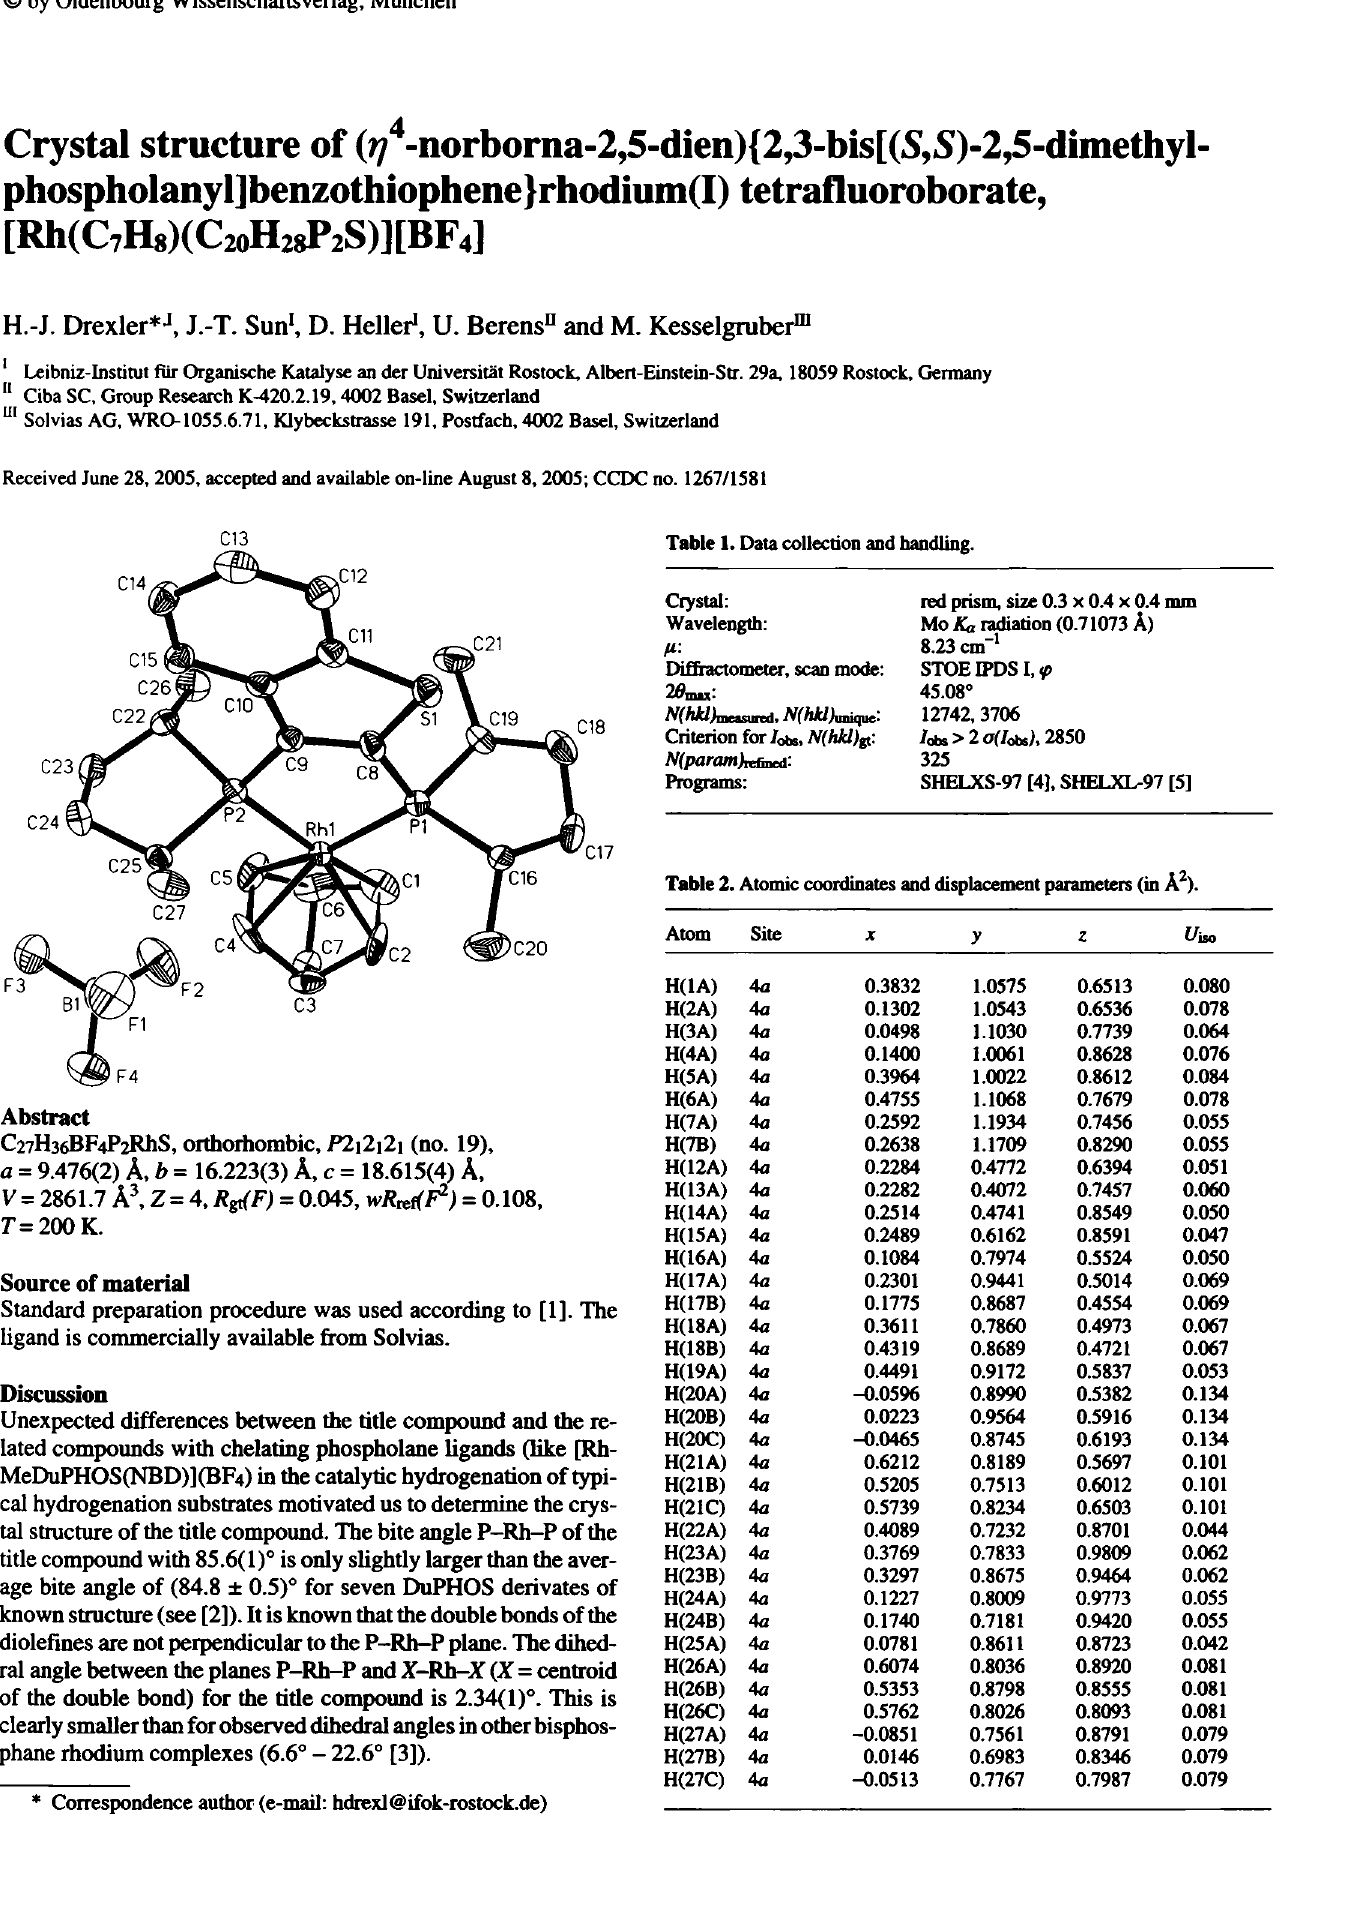
Table 2. Atomic coordinates and displacement parameters (in Ä 2